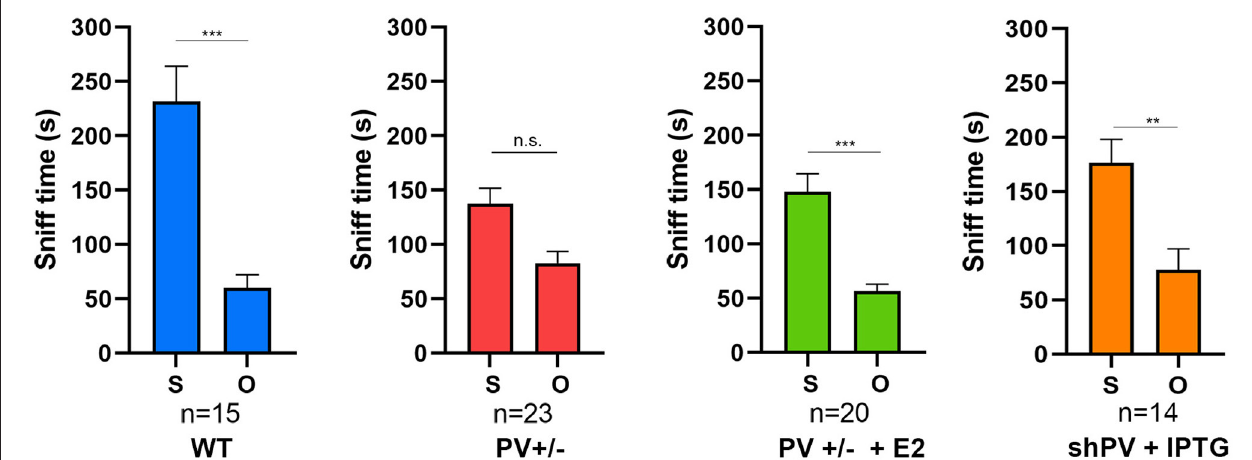
FIGURE 4 | In the three-chamber assay testing social preference during a 10min (600s) observation period, the sniffing time is longer with a stranger mouse (S) than with an empty cage (O) in WT mice, an effect that is lost in constitutive PV + / − mice (red bars). The preference for S is restored by upregulation of parvalbumin (PV) induced by E2 treatment (green bars). Data for the first three groups were previously reported ( Filice et al., 2018). The preference for S is attenuated in shPV mice, in which PV is downregulated by isopropyl- β - D -thiogalactoside (IPTG) from PND18–24 (orange bars). Data for IPTG-treated shPV mice is original. All mice were tested at PND25. In the same shPV mice without IPTG treatment (sham-treated), the preference for S is similar to that of WT mice (data not shown). Data for the first three groups are from Filice et al. (2018). All other experimental details on breeding, testing, and data analysis can be found in Filice et al. (2018) and Wöhr et al. (2015). *Represents a significant preference for S over O. ** p < 0.01, *** p < 0.001; n.s., not